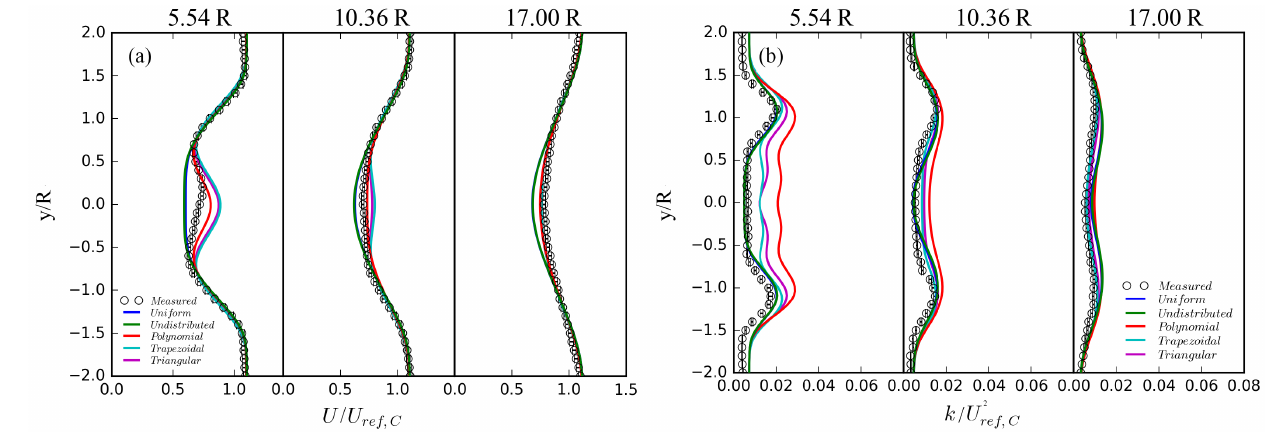
Figure 12. (a) Normalized axial velocity and (b) normalized turbulence kinetic energy computed for the two in-line model wind turbines (case C1) at x/R = 5 . 54, 10.36 and 17.00 downstream of the first wind turbine. Different thrust distributions and the k - ε turbulence model are used.